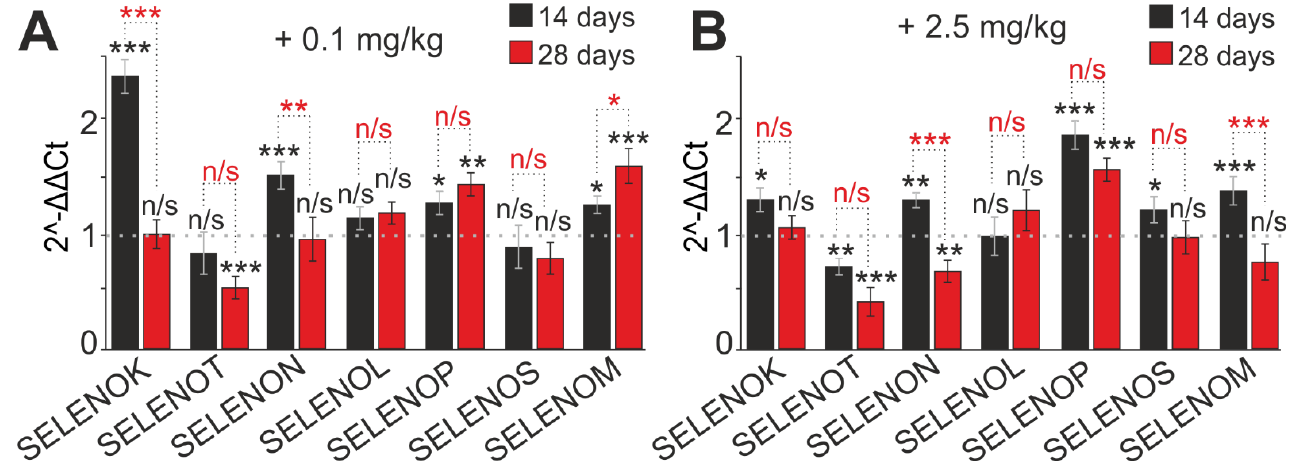
Figure 8. Effect of SeNPs applied in vivo on expression of selenoproteins encoding genes in the neutrophils. Relative mRNA expression of genes encoding selenoproteins 14 (black bars) and 28 (red bars) days after SeNP daily injection in concentrations 0.1 mg Se/kg ( A ) and 2.5 mg Se/kg ( B ). Dashed line — level of gene expression in controls (mice with administration of saline). GAPDH was used as housekeeping gene. Data are expressed as mean ± SEM of five independent experiments. Statistical analysis of experimental groups versus control was performed with paired t -test and marked with black asterisks. Significance between experimental groups marked with red asterisks: *** p < 0.001, ** p < 0.01, and * p < 0.05; n/s — no significance.